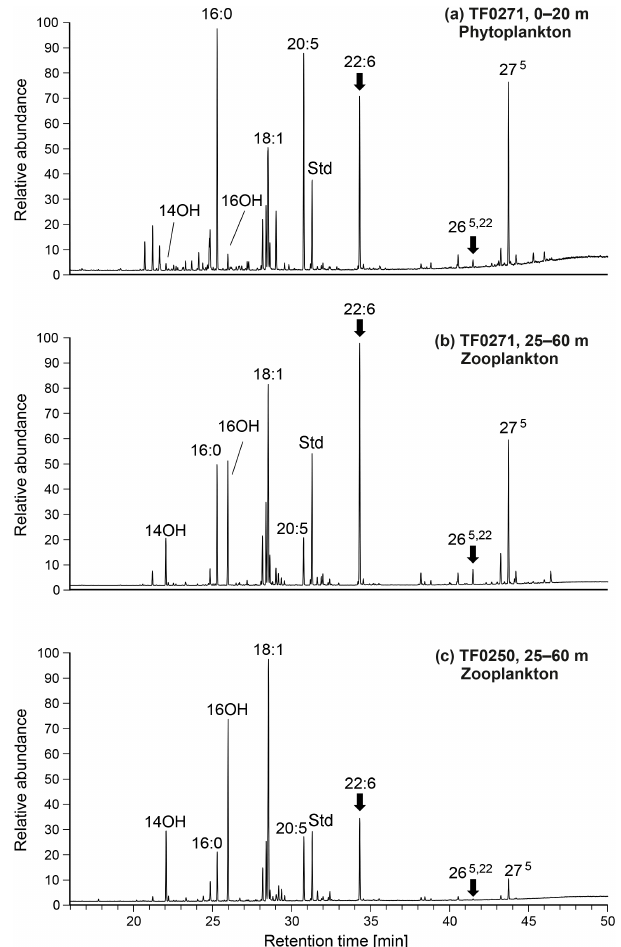
Figure 11. GC–MS chromatograms of neutral lipids (methyl es- ter/TMS derivatives) from mixed-layer phytoplankton (a) and sub- thermocline zooplankton (b) at station TF0271 (with a distinct sub- thermocline methane enrichment). Data from subthermocline zoo- plankton at TF0250 (without a distinct subthermocline methane enrichment) are shown as a reference (c) . Main compounds are labelled and interpreted as follows (see text for further discus- sion); 16:0, n -hexadecanoic acid (unspecific, high in bacteria); 14OH / 16OH, n -tetradecanol and n -hexadecanol (copepod wax es- ters); 18:1, oleic acid (unspecific, high in heterotrophs but also in (cyano)bacteria); 20:5, n -eicosapentaenoic acid (phytoplankton, high in diatoms); Std, internal standard; 22:6, n -docosahexaenoic acid (phytoplankton, high in Dinophyceae); 26 5 , 22 , 24-norcholesta- 5,22-dien-3 β -ol (specific for Dinophyceae); 27 5 , cholesterol (un- specific, high in zooplankton, but also found in some algae in- cluding Dinophyceae). Compounds indicating contributions from Dinophyceae-derived lipids are highlighted with an arrow. Note en- hanced levels of these biomarkers in T. longicornis -dominated zoo- plankton at the station with a distinct subthermocline methane en- richment